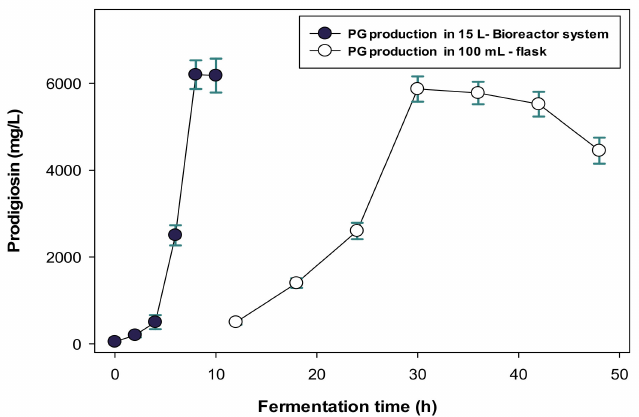
Figure 4. Production of PG in a 15 L bioreactor system and 100 mL flask for different periods of time. The error bars in the figures are standard errors